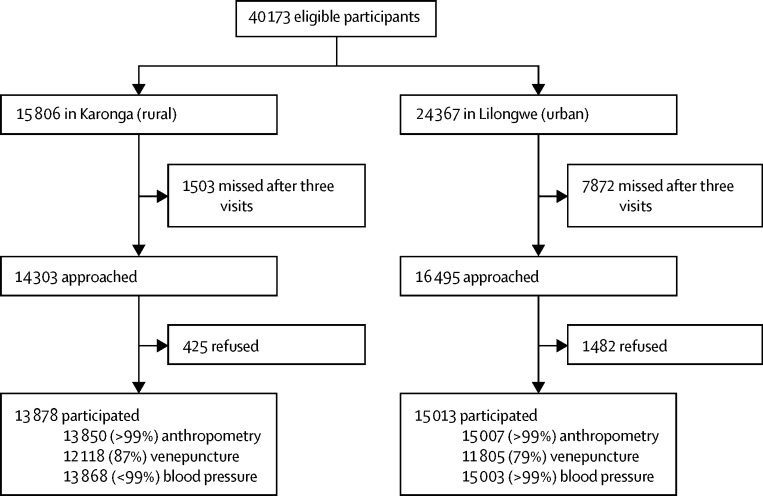
Flow chart of study participation by site